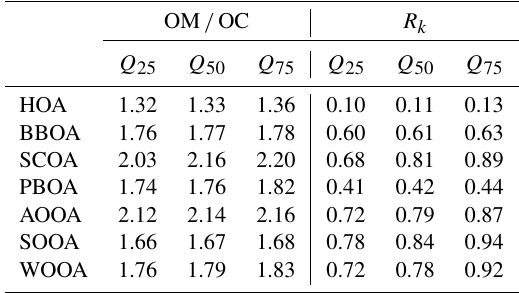
Table 2. Variability of OM / OC and factor